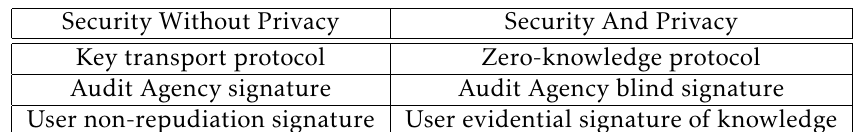
Table 1. Mechanisms Comparison